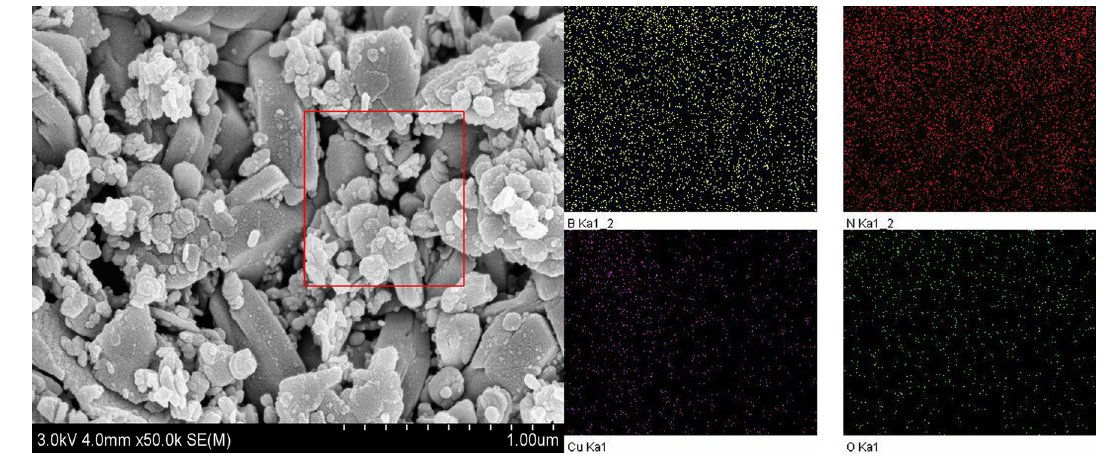
Fig.7 Dispersion properties of oil with additives, from left to right, BNNS, CuO, PDA-BNNS, f-CuO, and